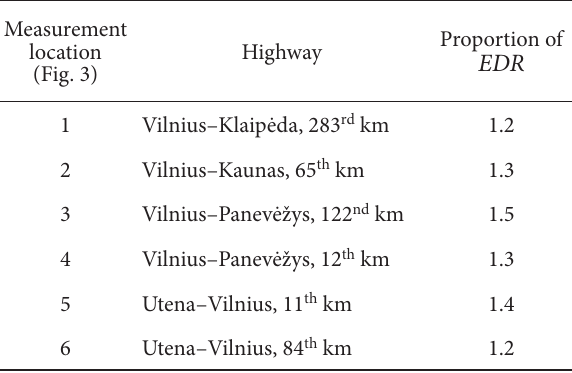
Table 1. Proportion of EDR above some AC of highways and their sides Measurement